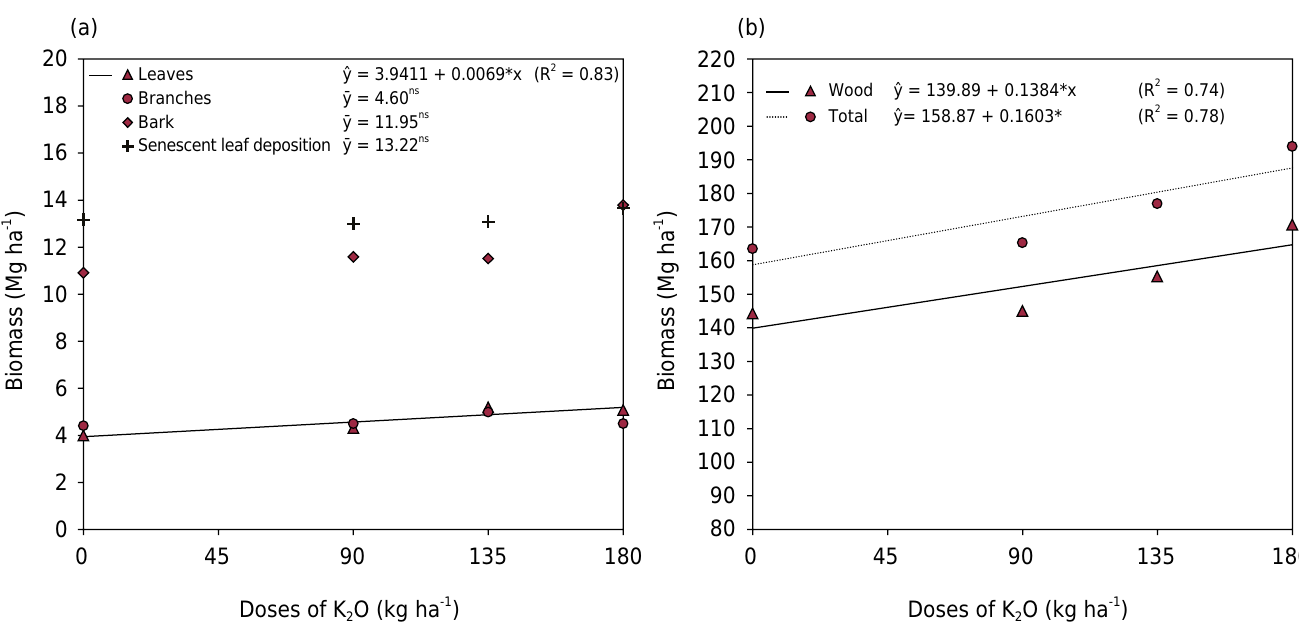
Figure 2. Biomass of leaves, branches, bark, senescent leaf deposition (a), wood and total of the aerial part (b) of E. urophylla hybrid, evaluated at 66 months after planting, as a function of doses of K 2